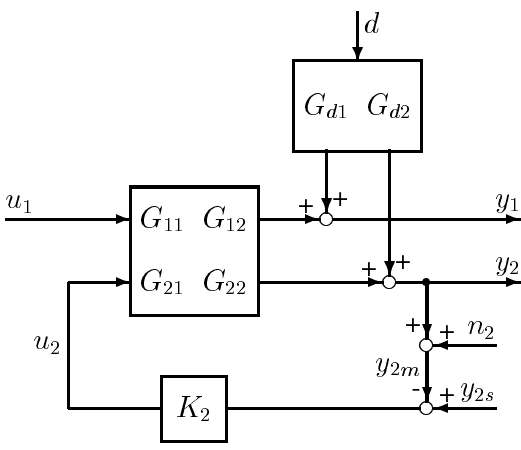
Figure 2. Block diagram of a partially controlled